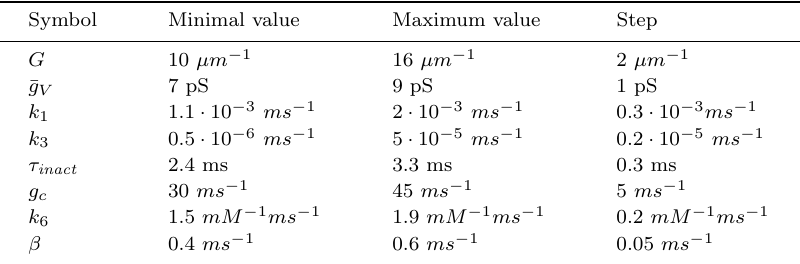
Table 1. The list of adjusted parameters involved in model. Symbol